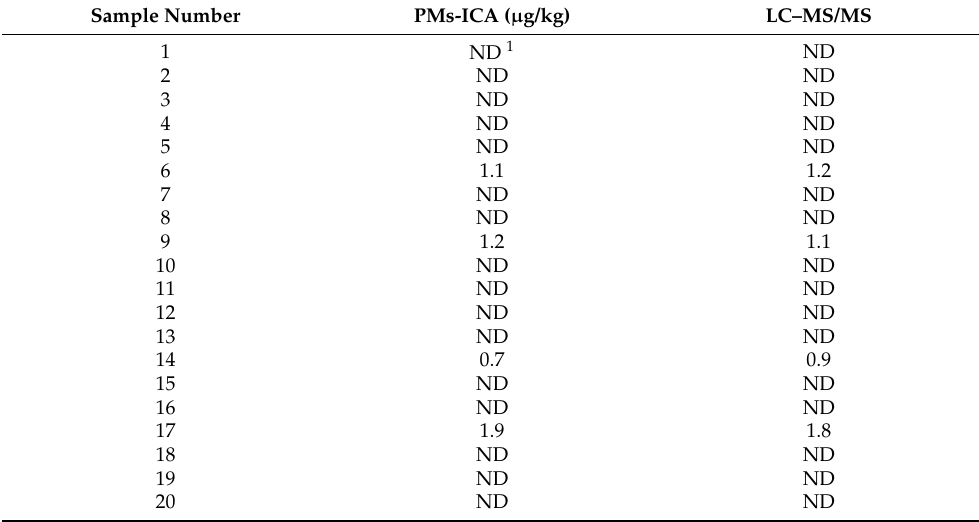
Table 4. Detection result of real maize samples using PMs-ICA and LC–MS/MS ( n =